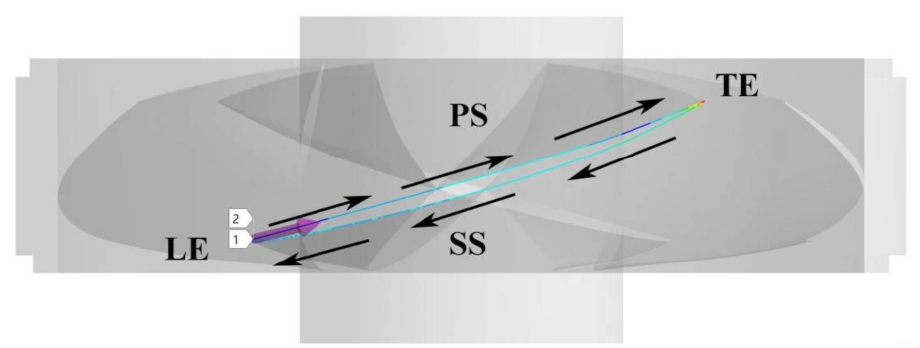
Figure 13. The wire frame path at the blade